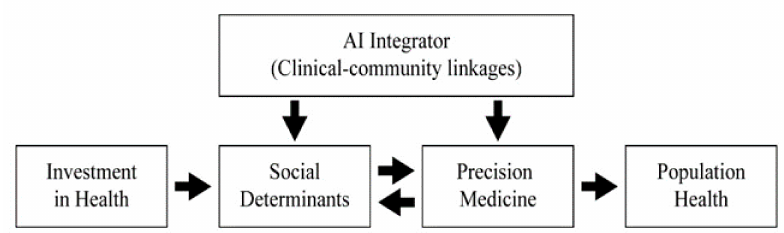
Figure 1. Roadmap to population